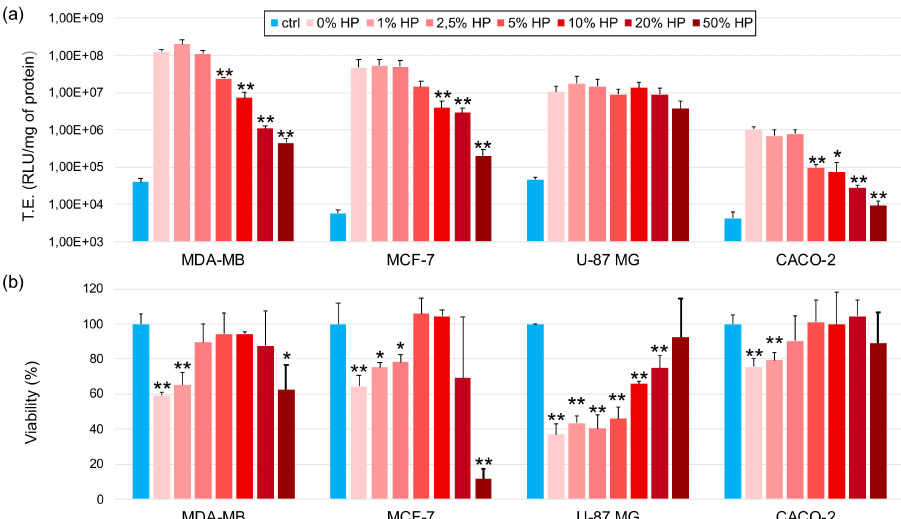
Figure 4. Transfection efficiency (TE, panel a ) and cell viability (panel b ) of biocoronated grapholipoplexes at di ff erent plasma concentrations in MDA-MB, MCF-7, U-87 MG and CACO-2 cells. Untreated cells (blue bars) were used as a control (ctrl) in both experiments. Results are given as average of six independent measurements ± S.D. Statistical significance was evaluated using Student’s t -test (* p < 0.05; ** p < 0.01; no asterisk means lack of significance) with respect to pristine grapholipoplexes (i.e., 0% HP) and untreated cells in TE and cell viability experiments,